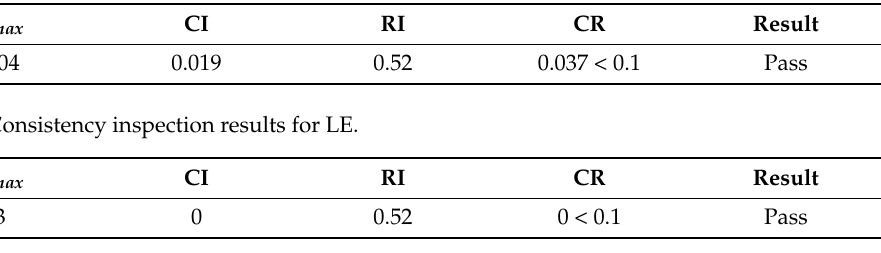
Table 4. Weights of the production-living-ecological space and sustainable development indicators. Type of Space Weights Indicators Weights Production Space Living Space Ecological Space Table 5. Consistency test results for the LP.